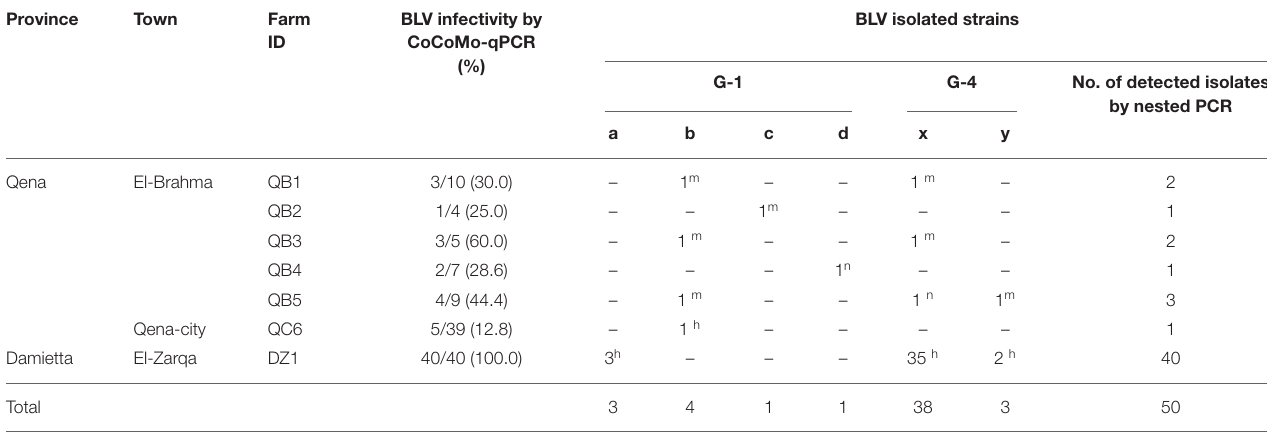
TABLE 2 | Distribution of the six genetically distinct BLV strains circulating in Egypt cattle throughout the infected dairy farms.